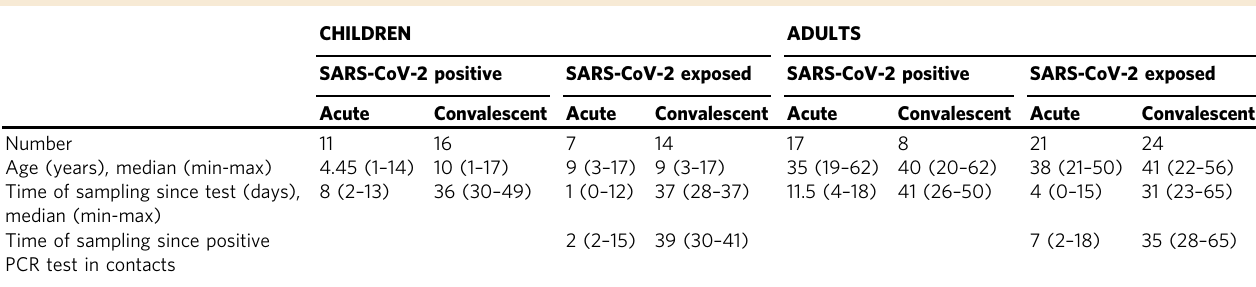
Table 1 Demographics of study